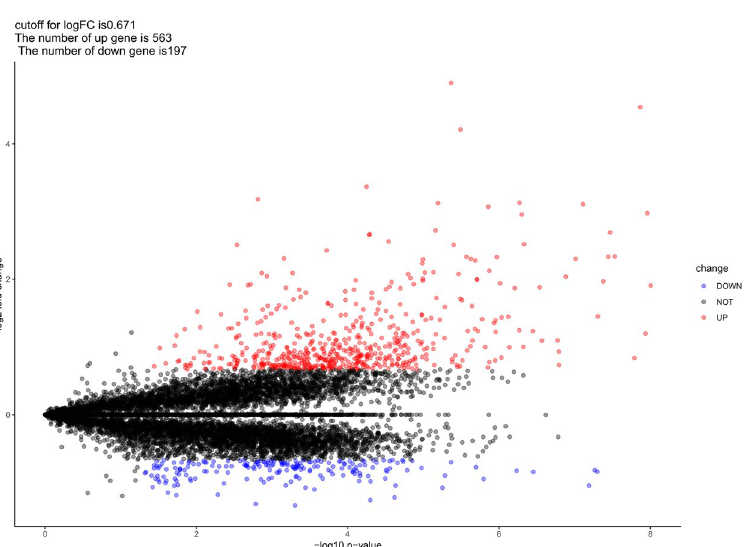
Figure 5. Volcano map of DEMs. Up-regulated genes are represented by red spots while down-regulated genes by blue